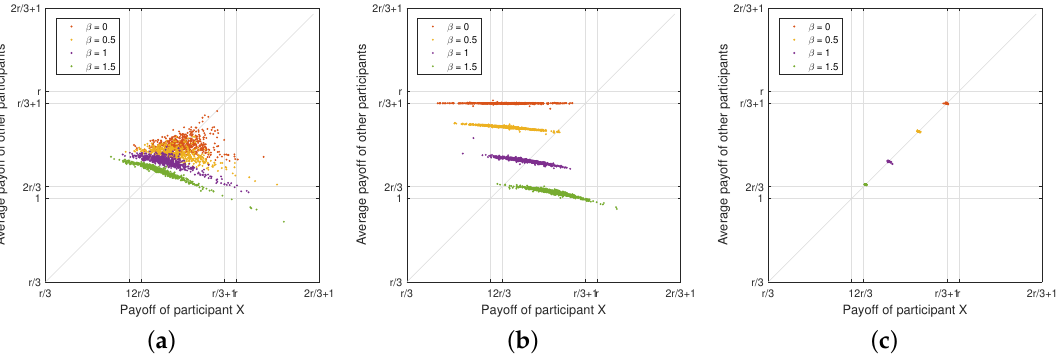
Figure 3. The payoff of the some typical strategies [26] (reproduced with permission from Xinyu Yang, Xiaofei He, Jie Lin, Wei Yu, Qingyu Yang, A Game-Theoretic Model on Coalitional Attacks in Smart Grid; published by IEEE, 2016). ( a ) Win-Stay-Lose-Shift (WSLS) versus Random Strategy; ( b ) Equalizer versus Random Strategy; ( c ) all with Equalizer